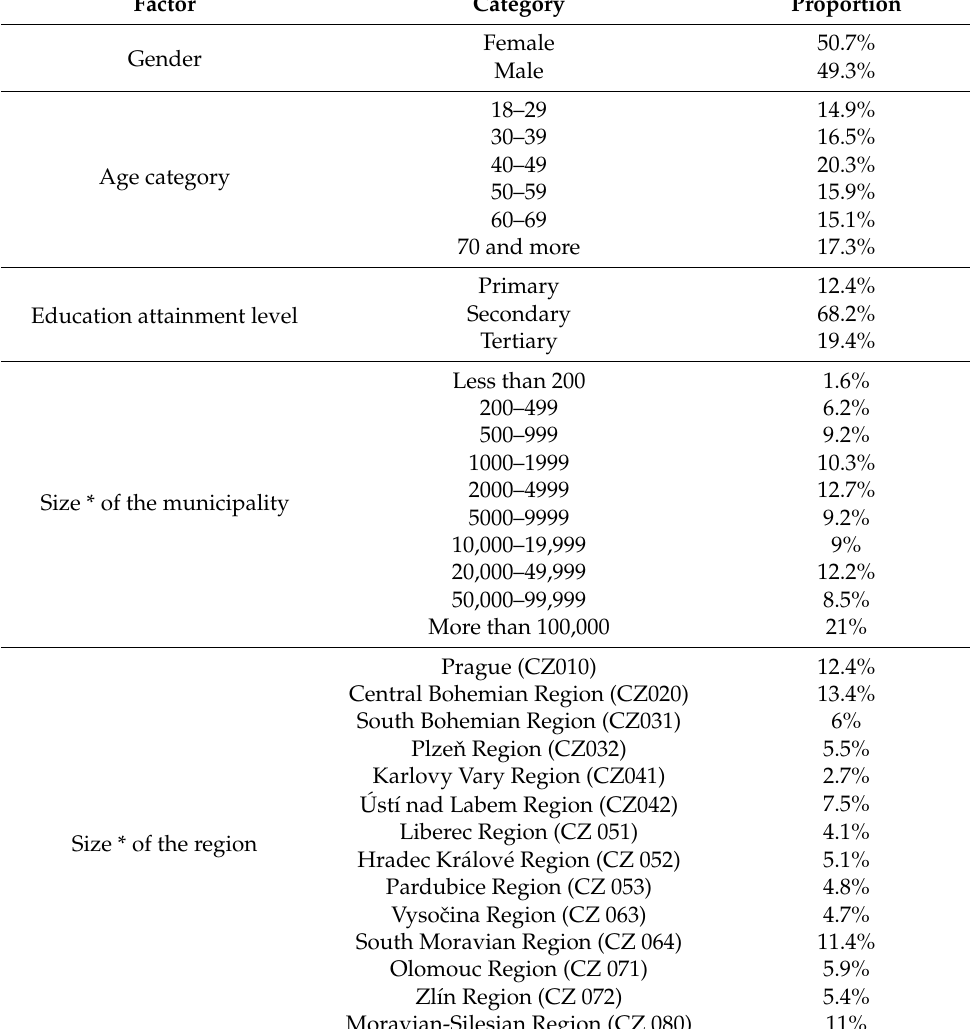
Table 2. Representative proportions of selected factors in the Czech Republic, based on